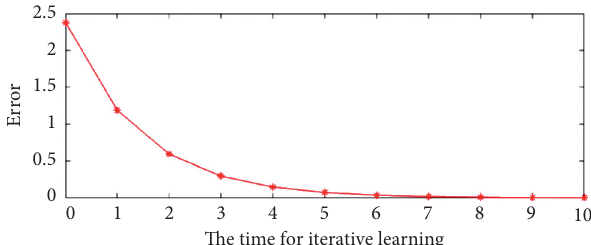
Figure 6: The error varies with the time for iteration